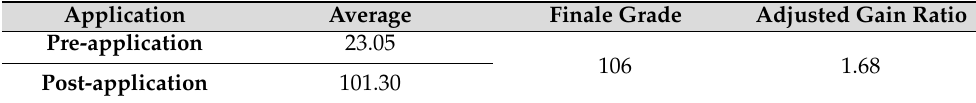
Table 9. Black adjusted gain ratios.